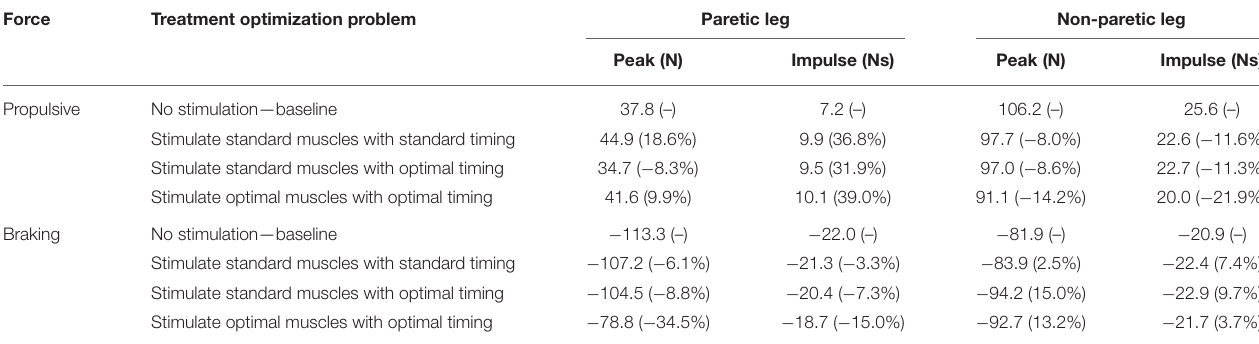
TABLE 8 | Peak and impulse of propulsive force and breaking force for the paretic and non-paretic leg for the baseline optimization with no muscle stimulation and the three FastFES treatment optimizations, along with percent reductions relative to baseline (indicated in parentheses).